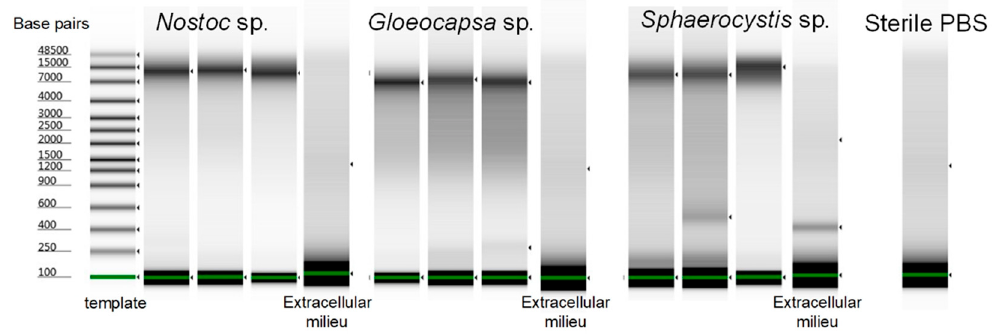
Figure 10. The Tapestation results of amplified DNA from single Nostoc sp., Gloeocapsa sp. and Sphaerocystis sp. cells using the optimized protocol. The DNA was not degraded. Three single cells from each species were shown.